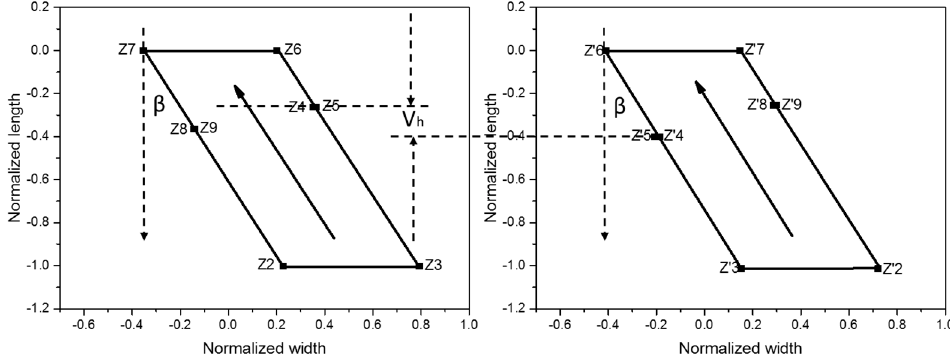
Figure 4. Results of conformal mapping of double three-contact vertical Hall devices.